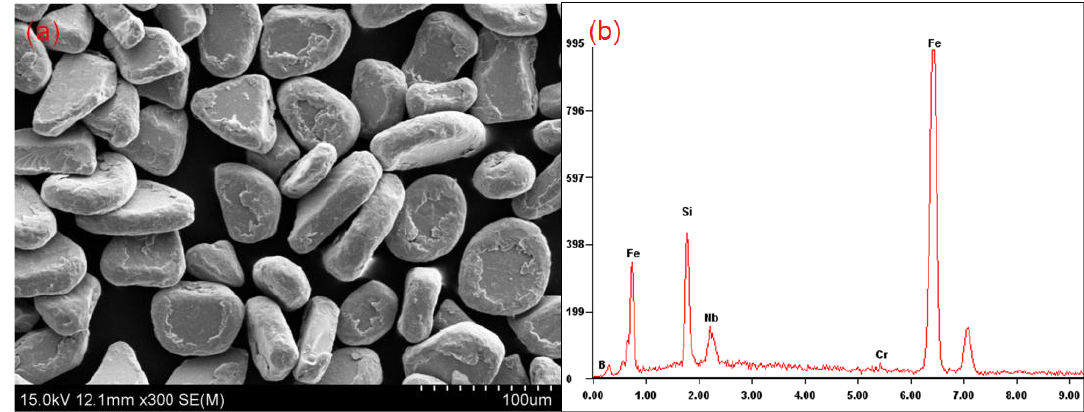
Figure 1. ( a ) SEM micrograph of the original powders, ( b ) peaks of elements.